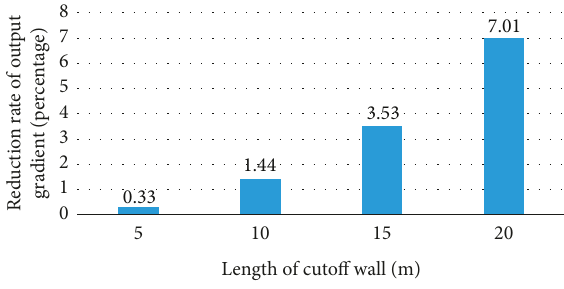
Figure 8: Percentage of exit gradient changes. Table 5: The values of the parameters in point no 1. Figure 9: Percentage of changes in total seepage in Sections 1 and 2. Parameter Value Total seepage from Section 1 (m 3 /s/m 2 ) 0.019689 Total seepage from Section 2 (m 3 /s/m 2 ) 0.017499 Average uplift pressure (MPa) 560.13 0.96423